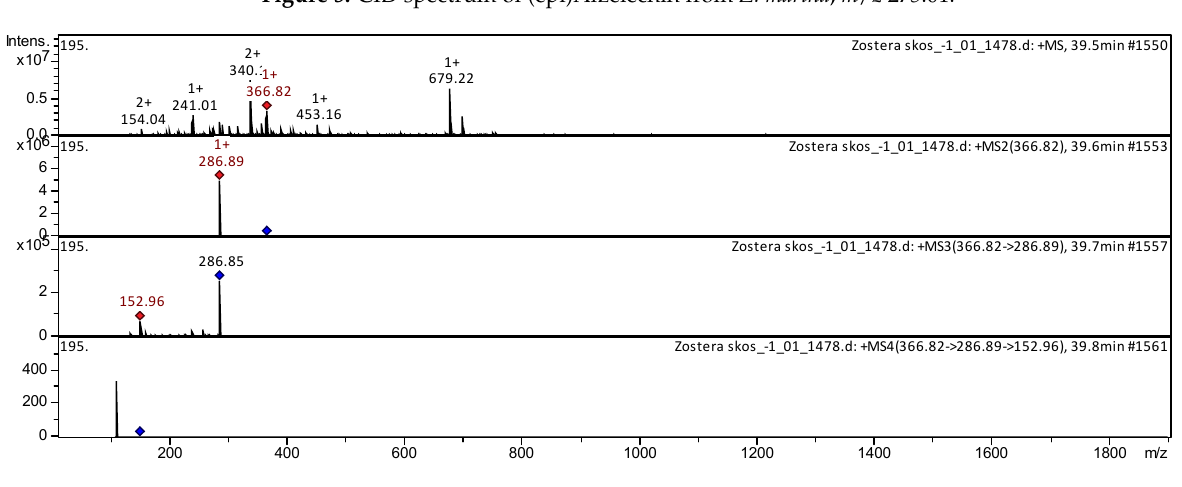
Figure 6. CID spectrum of Luteolin 7–sulfate from Z. marina , m/z 366.82. [M+H] + ion produced one fragment ion with m/z 286.89 (Figure 6). The fragment ion